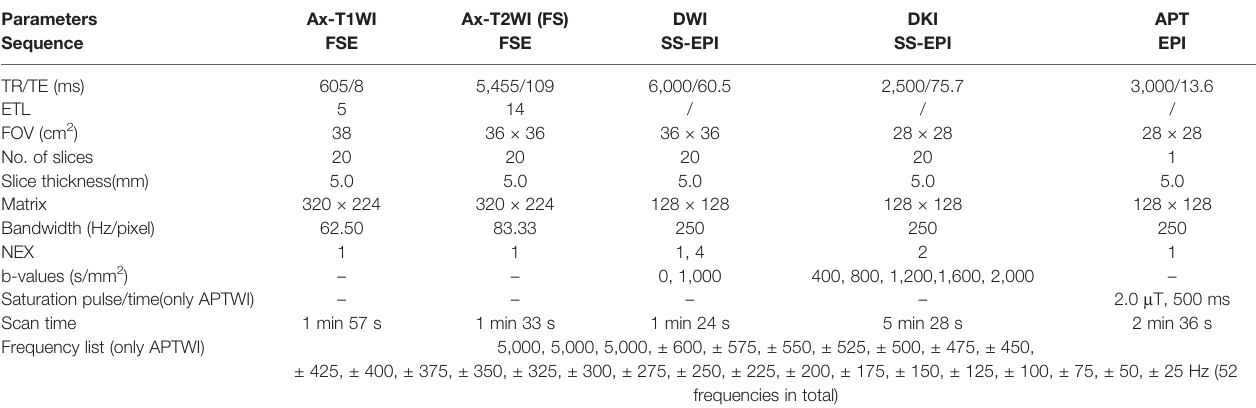
TABLE 1 | Scanning parameters.